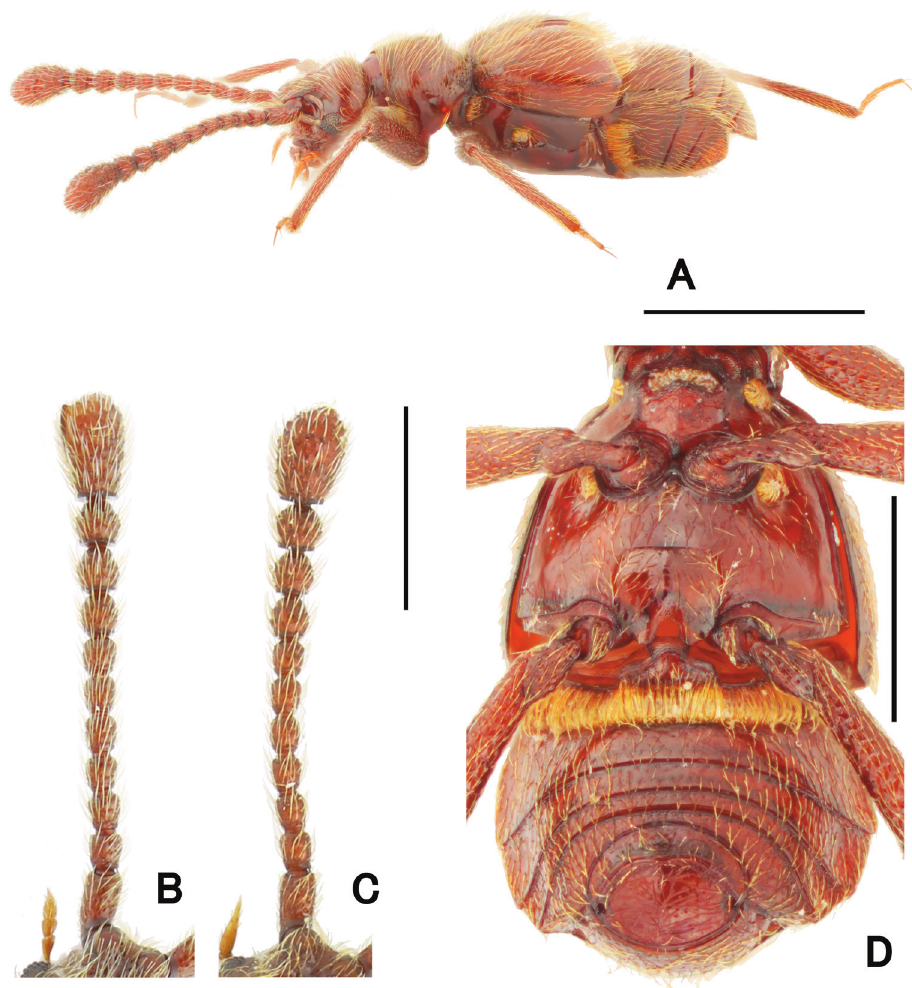
Figure 2. Morphological details of Pseudophanias yaimensis A habitus in lateral view B male antenna C female antenna D male metaventrite. Scale bars: 1.0 mm ( A ); 0.5 mm ( D ); 0.2 mm ( B, C